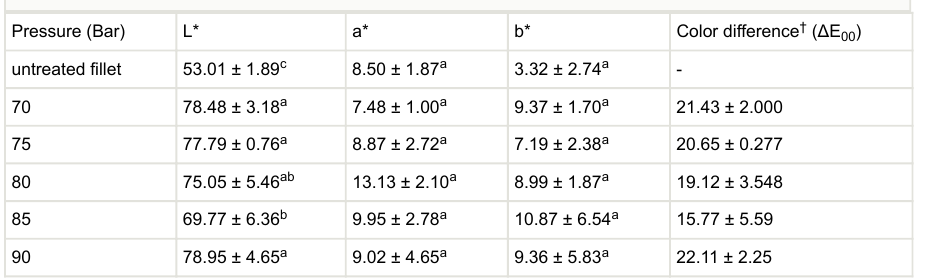
Table 1. Effect of CO pressure at 40 °C on fillet color.